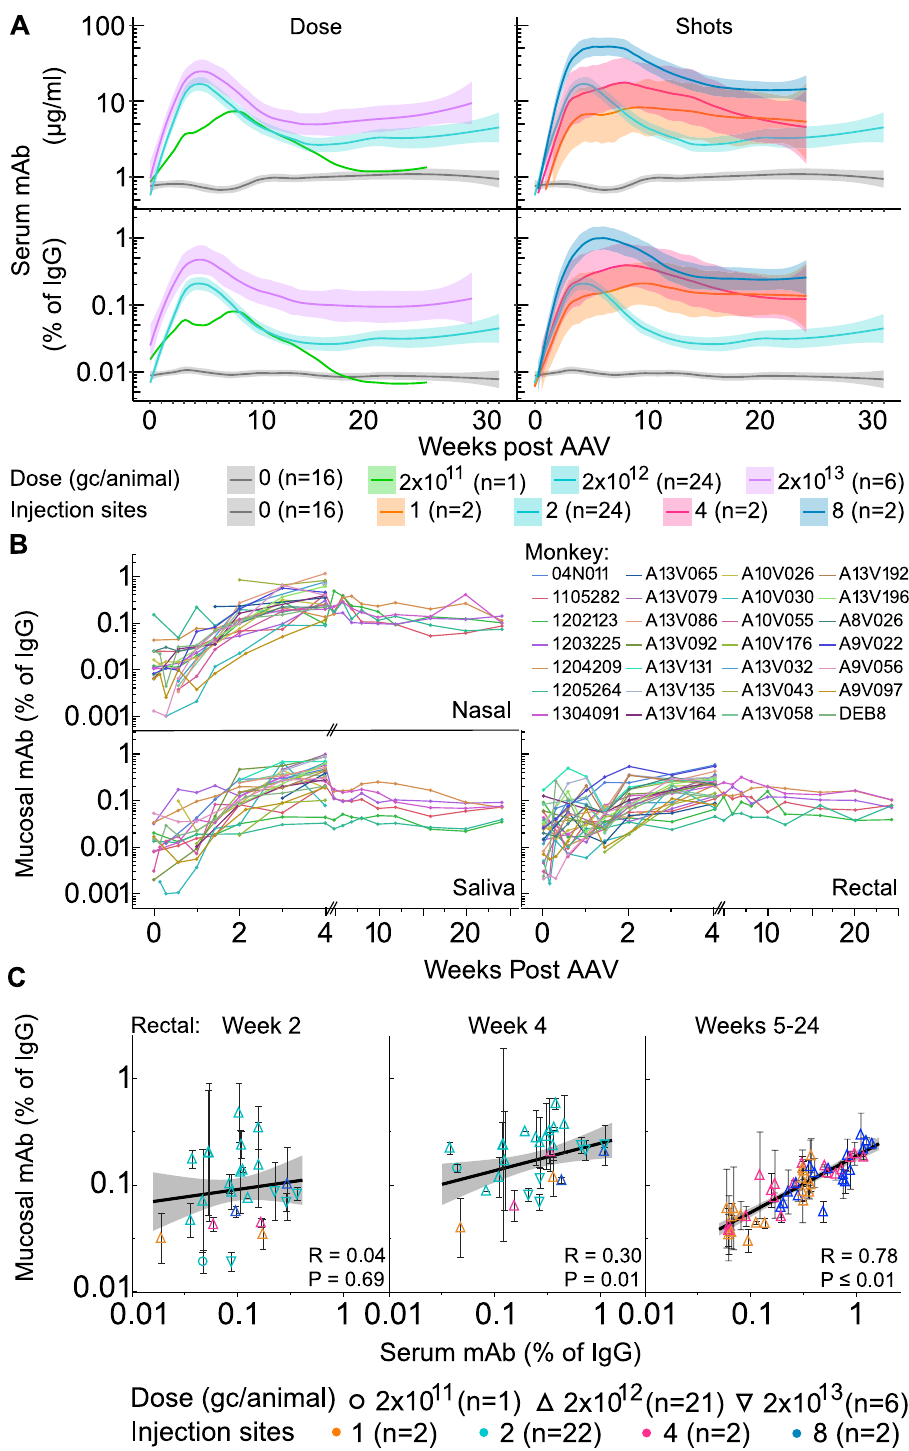
Fig 3. Dose and injection site number titration of AAV administration. (A) Absolute (upper panels) or fractional (lower panels) serum antibody levels of ITS01, ITS06.02 or both are shown as a smoothed fit with 95% confidence interval shading for varying doses (left panels) or shots (right panels). At the lowest dose, data for a single animal is shown (the other one animal showed no expression of transgene). Animals received 2 injections into the quadriceps with AAV8-ITS01 and/or AAV8-ITS06.02 at low, medium, high doses (2 x 10 11 (n = 1; green), 2 x 10 12 (n = 24; cyan), 2 x 10 13 (n = 6; violet) gc/animal, respectively). Controls received no injections (n = 16; gray). For varying shots,